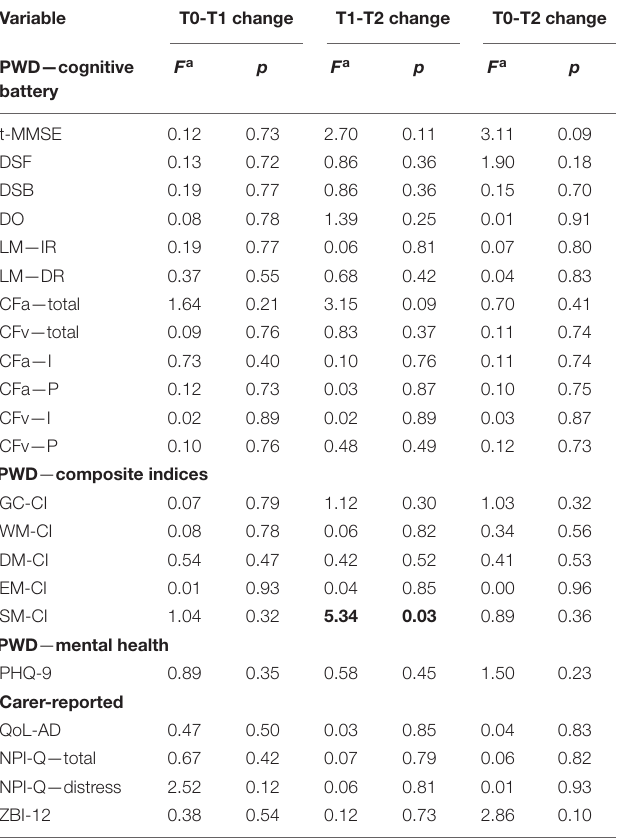
TABLE 2 | Changes in cognitive and clinical variables over the 6 months of